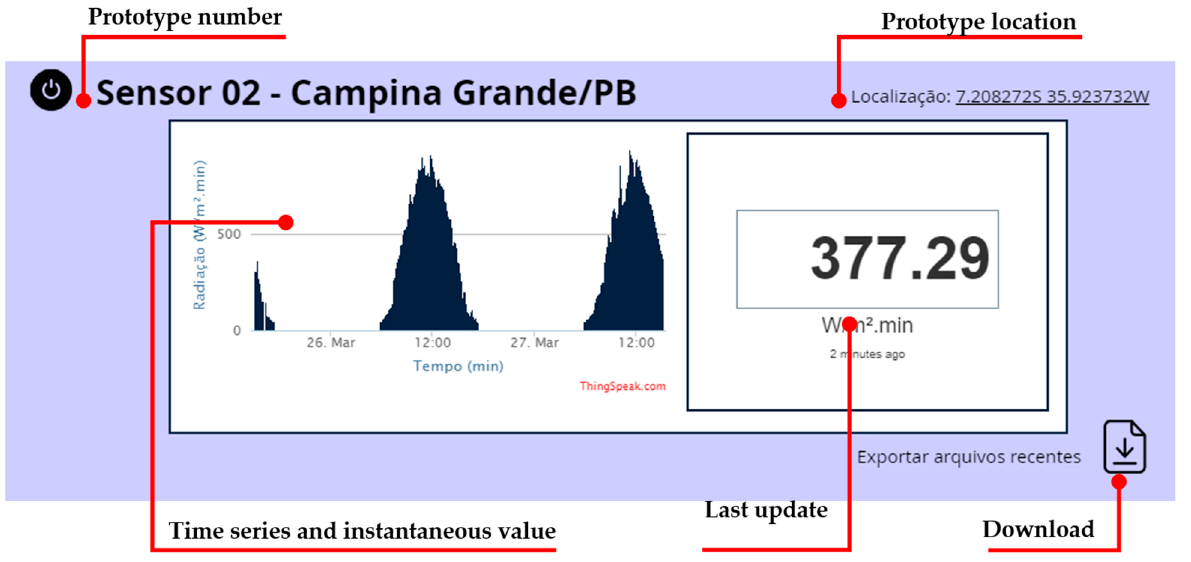
Figure 8. Data visualization web interface with its principal information.